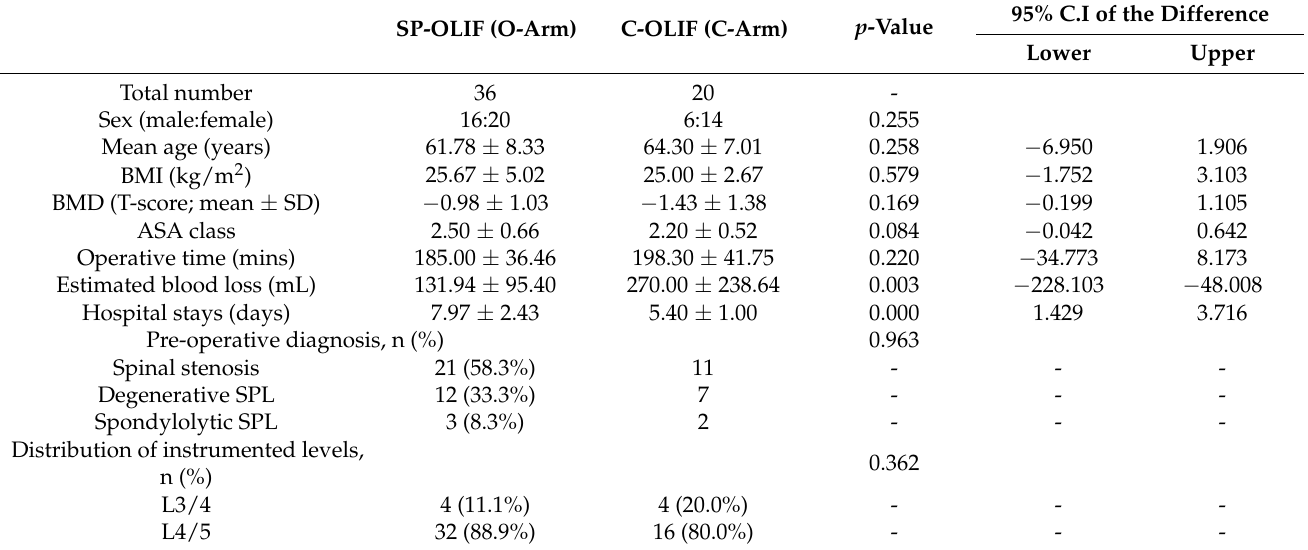
Table 1. Demographic characteristics of the patients.